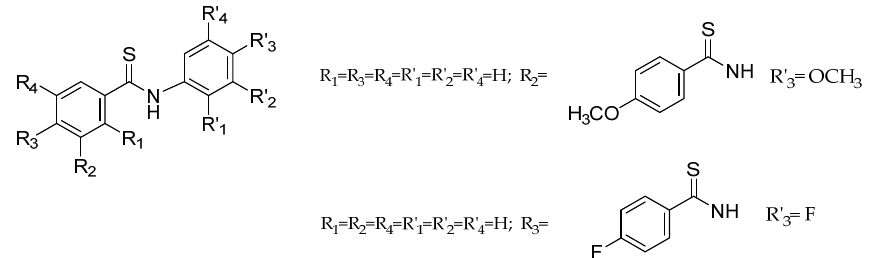
Figure 3. Structure of the thiobenzanilides showing antiproliferative activity against estrogen- dependent MCF-7 cancer cells [22].